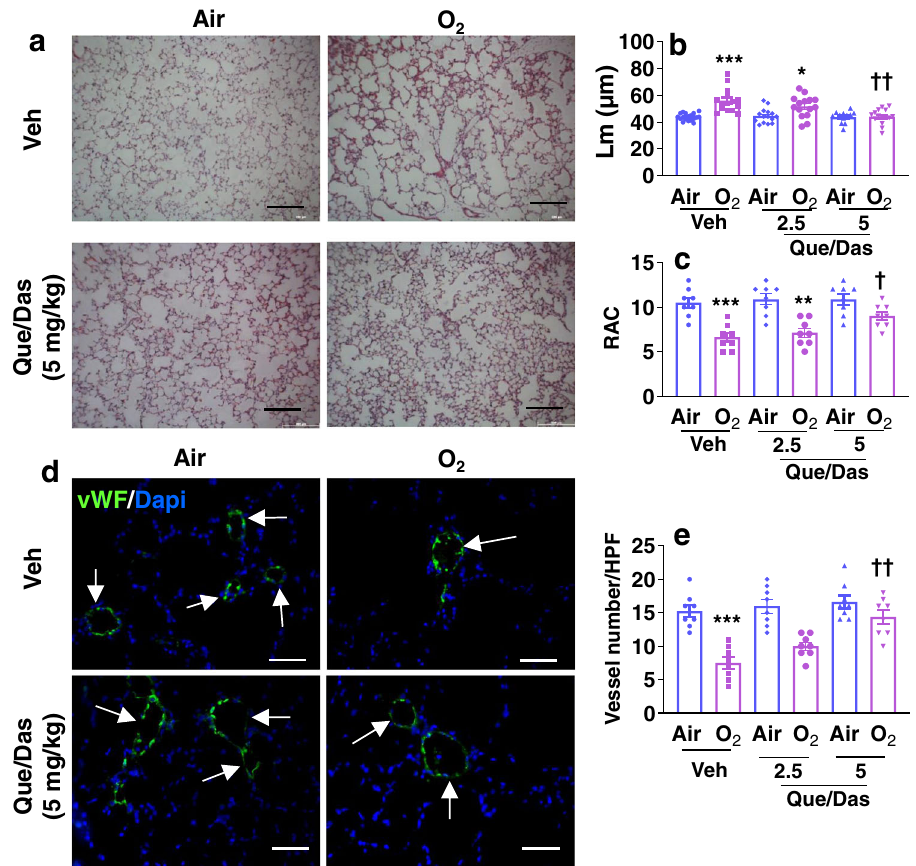
Fig. 7 | Treatment with a senolytic cocktail during the alveolar stage protects against hyperoxia-induced alveolar and vascular simpli fi cation. C57BL/6J neonatal mice (<12h old) were exposed to air or hyperoxia (>95% O 2 ) for 3 days followedbyairrecoveryuntilpnd7orpnd14.Quercetin(Que,Q)/dasatinib(Das,D) (2.5 and 5mg/kg) were intraperitoneally injected into mice at pnd4 and pnd6. a H&E staining was performed in the lung of hyperoxia-exposed mice treated with Que/Das (2.5 and 5mg/kg) at pnd14. Bar size: 100 µ m. b , c Lm and RAC were